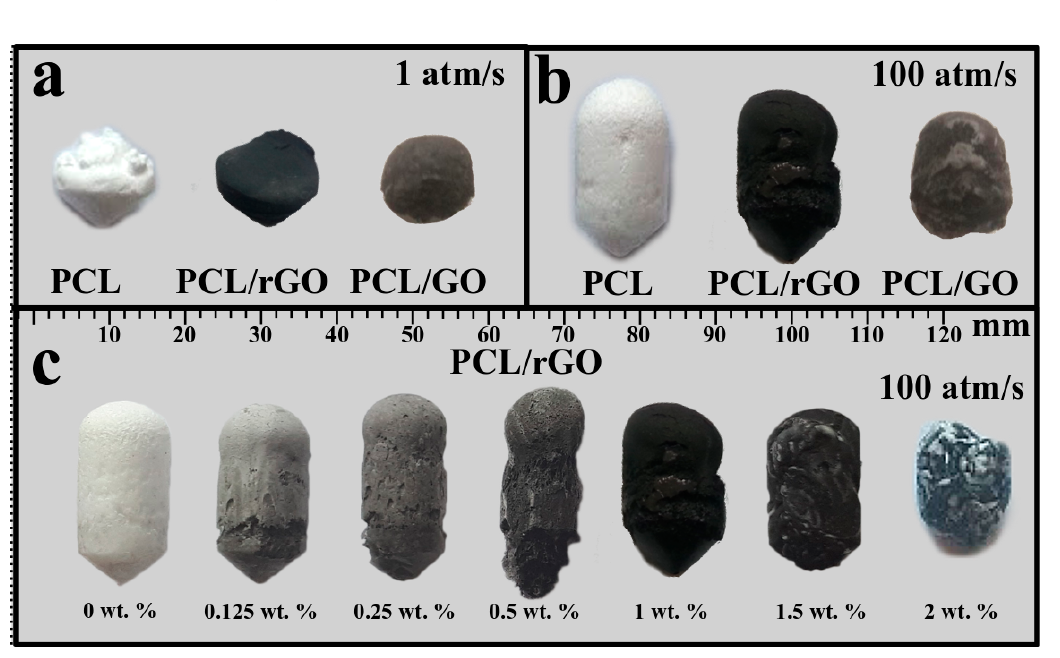
Figure 1. PCL, PCL/GO, PCL/rGO scaffolds produced at decompression rates of ( a ) 1 atm/s and ( b ) Figure 1. PCL, PCL / GO, PCL / rGO sca ff olds produced at decompression rates of ( a ) 1 atm / s and ( b ) 100 100 atm/s and ( с ) PCL/rGO scaffolds filled with different rGO concentrations. atm / s and ( c ) PCL / rGO sca ff olds filled with di ff erent rGO